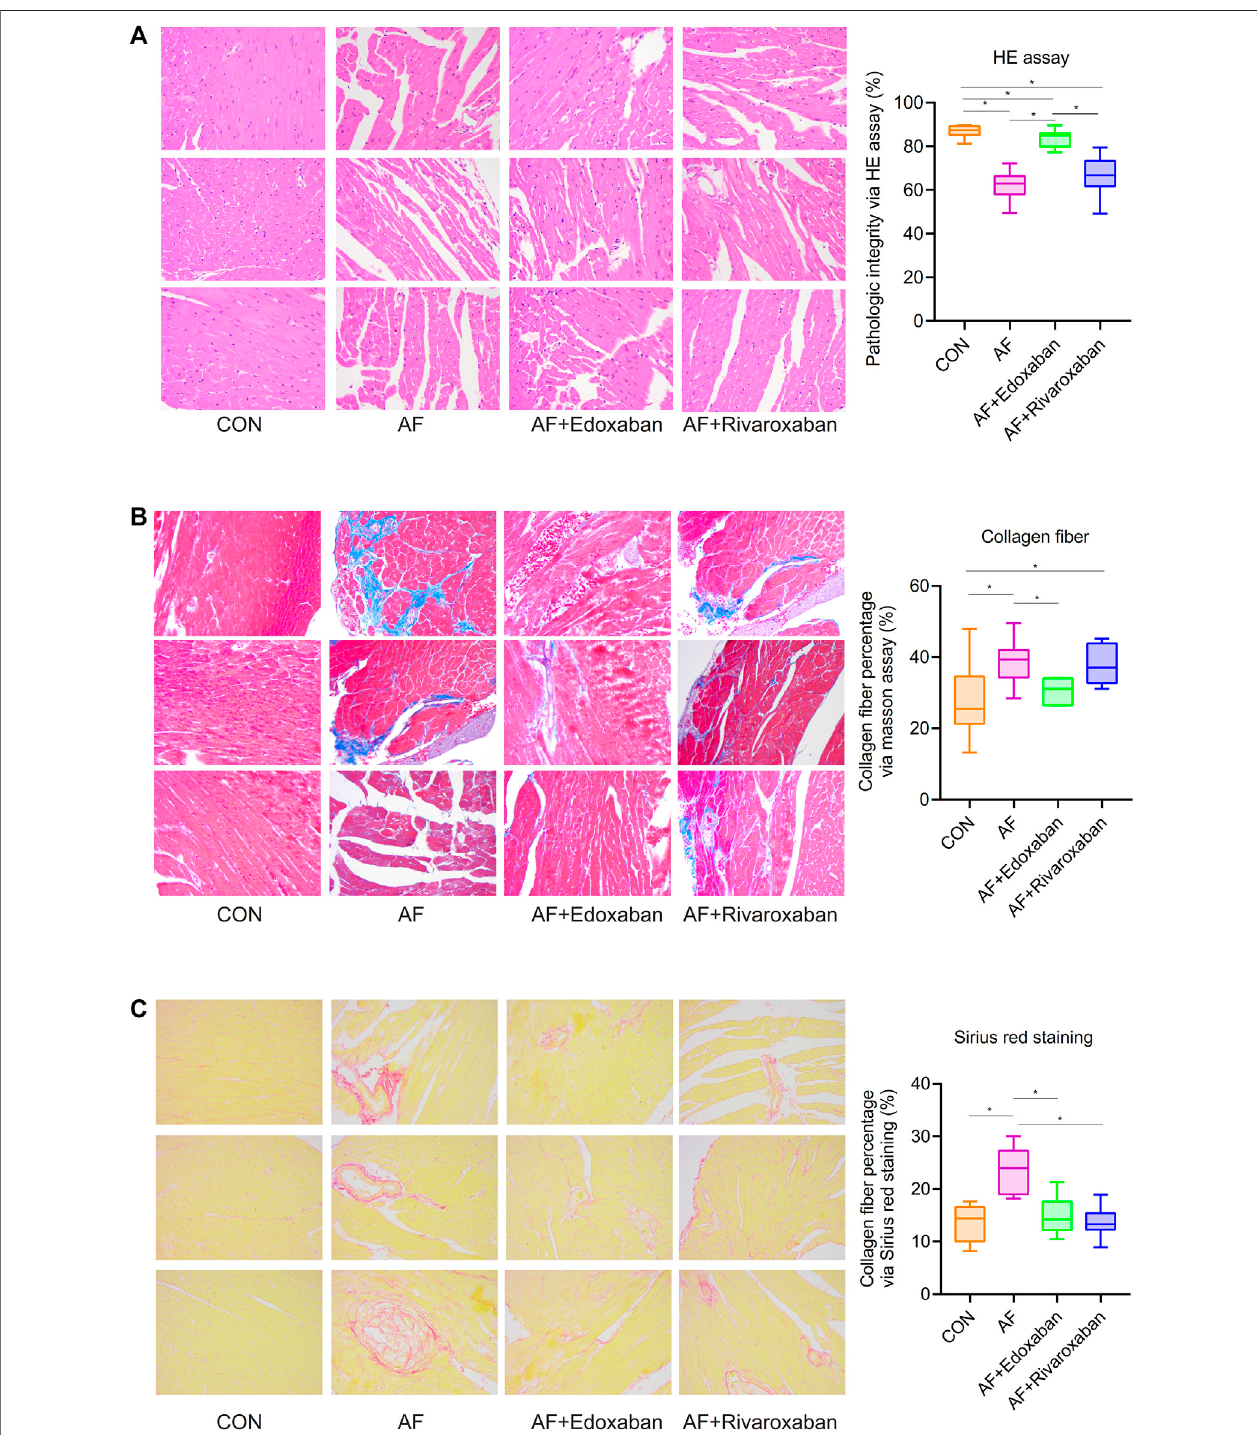
FIGURE 3 | Better effect of edoxaban on the pathogeny structure of cardiac muscle tissue and the different degrees of myocardial fi brosis in the four groups. (A) Structure of cardiac muscle tissue in the AF + edoxaban group was better than in the AF group and the AF + rivaroxaban group. (B) Through the Masson assay, compared withthe AF group, the collagen fi ber percentage in the AF +edoxaban group wasdecreased signi fi cantly. (C) Through Sirius red staining, compared with the AF group, the collagen fi ber percentage in the AF + edoxaban group was decreased signi fi cantly.